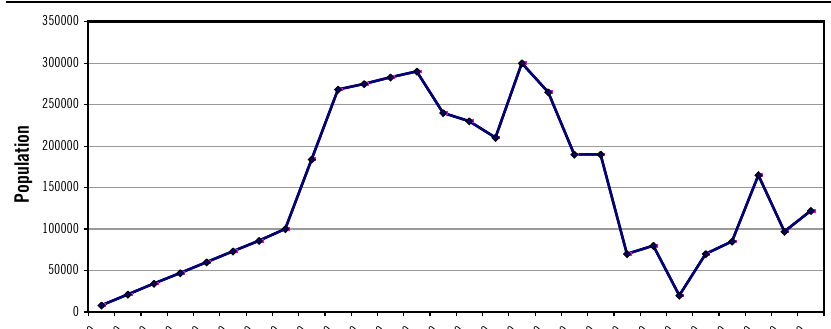
Figure 3 – Estimated Urban